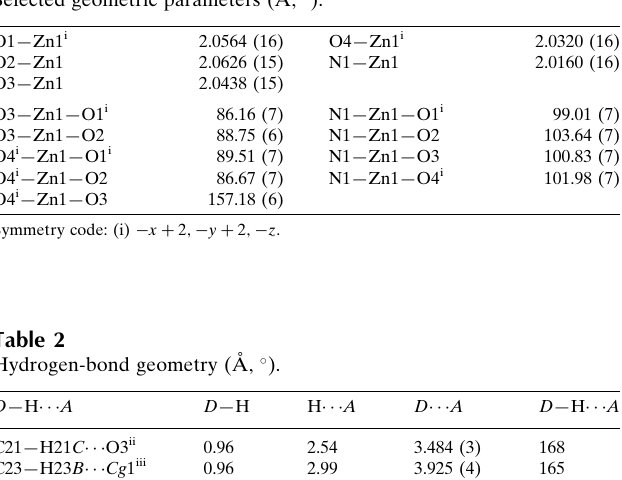
Selected geometric parameters (A˚ , (cid:3) ).